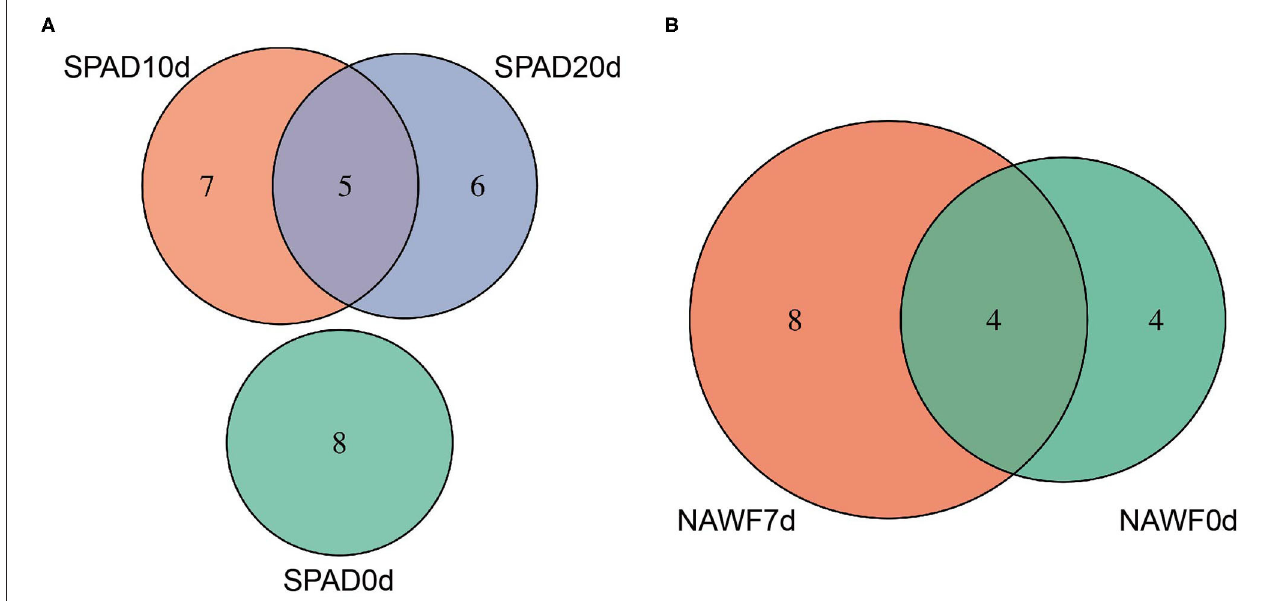
FIGURE 3 | Venn diagram of genomic loci for (A) SPAD and (B) NAWF traits.